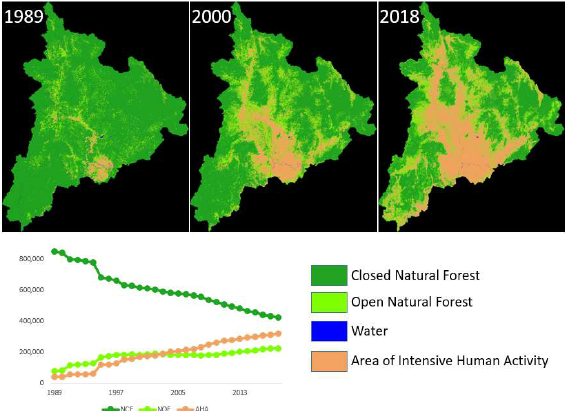
Figure 9. 30-year change of natural forests of Kon Tum province of Vietnam. Three classified images in upper part of the figure show land cover maps in years 1989, 2000 and 2018. Graph in lower part visualizes quantitative changes closed and open natural forest and area of intense human